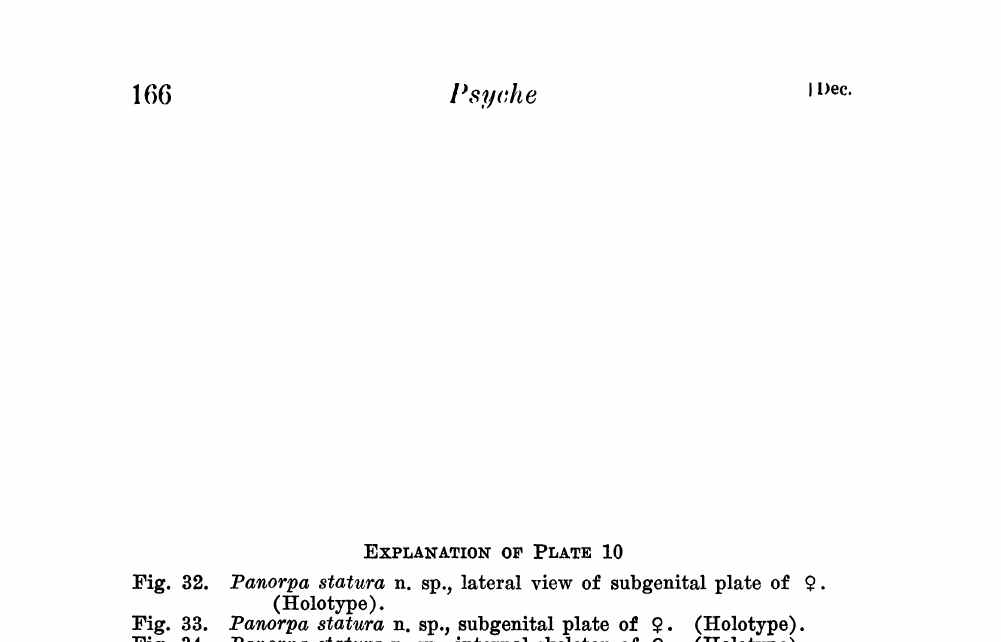
32. 33. 34. 35. 36. 37. 38. 39. 40.